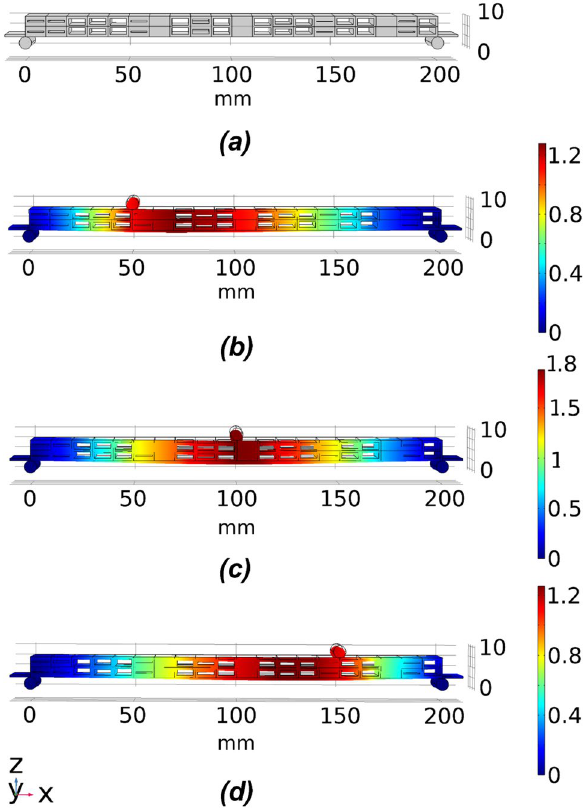
Figure 13. An example of the optimised 20 voxel double void beam model for the target set TS8. ( a ) The geometry of the optimised beam model and ( b–d ) are deflection plots under loading conditions 1 to 3, respectively.